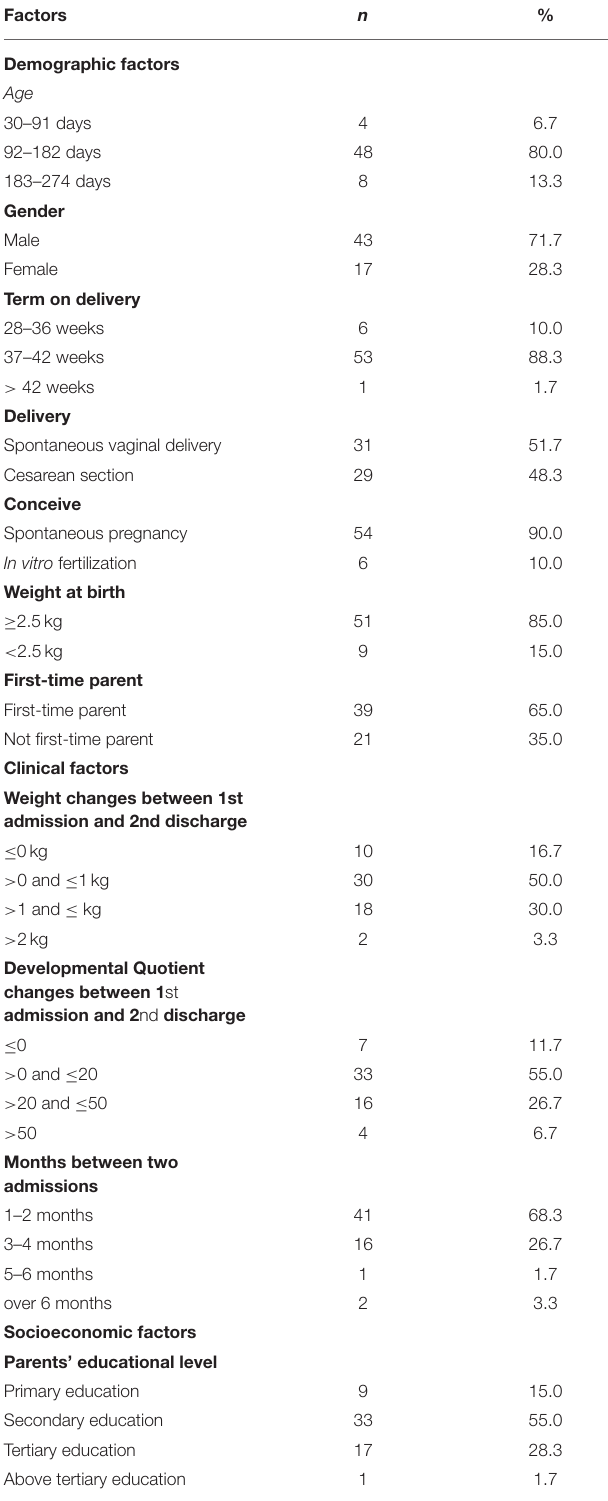
TABLE 1 | Demographic, clinical, and socioeconomic characteristics of patient samples ( n =